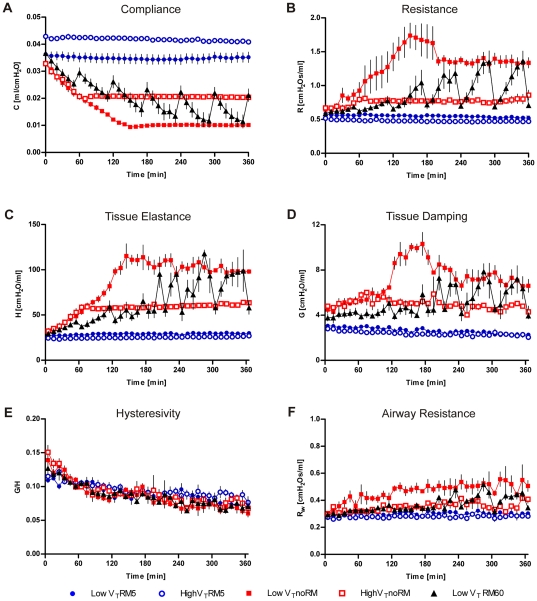
Lung mechanics.Mice were ventilated for six hours with low VT  = 8 mL/kg or high VT  = 16 mL/kg, PEEP  = 2 cmH2O and RM every five minutes (RM5), every 60 minutes (RM60) or without RM (noRM). Lung mechanics were measured every ten minutes by the forced oscillation technique. (LowVTRM5: n = 6, highVTRM5: n = 6, lowVTnoRM: n = 5, highVTnoRM: n = 4, lowVTRM60: n = 5). P-values for group comparisons are shown in supplementary Table S1.